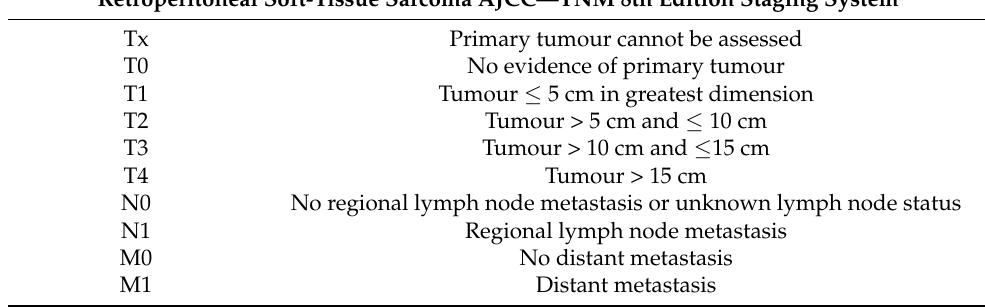
Table 1. The American Joint Committee on Cancer (AJCC) stage classification system, 8th edition for retroperitoneal